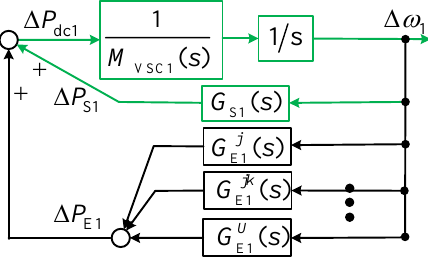
Figure 5. An equivalent model with the quantification of the interactions of a system with N